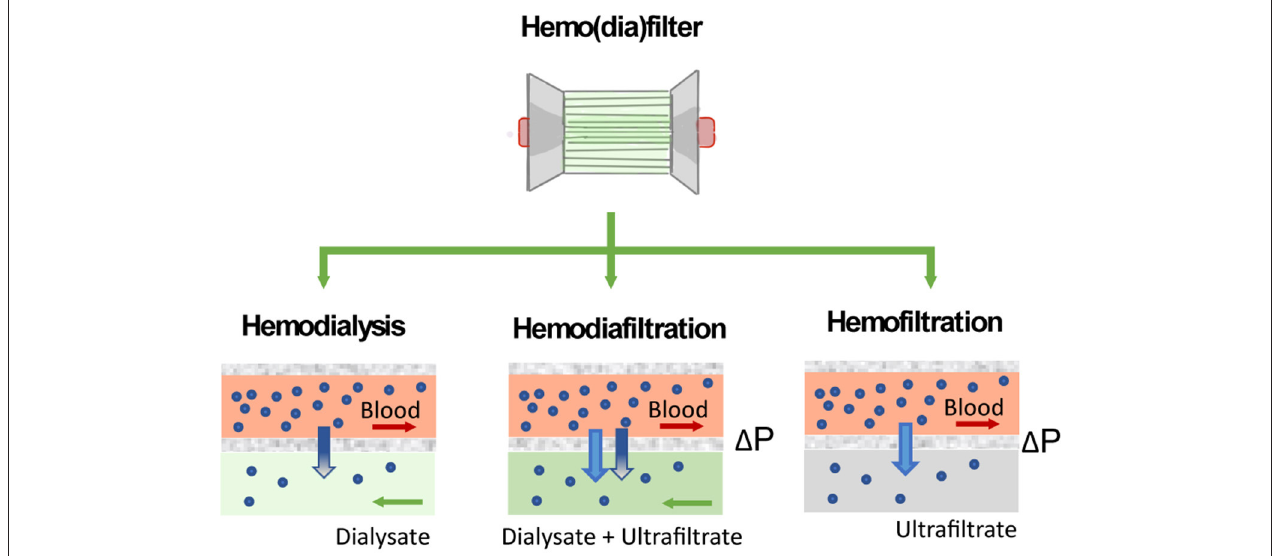
FIGURE 5 | Solute clearance in renal replacement therapy can be achieved by diffusion or convection. In diffusion-based methods (hemodialysis), solutes move down their concentration gradient from the bloodstream to a dialysate solution. Methods based on convection (hemofiltration) apply a pressure gradient ( 1 P) to force solutes and fluid flow across the